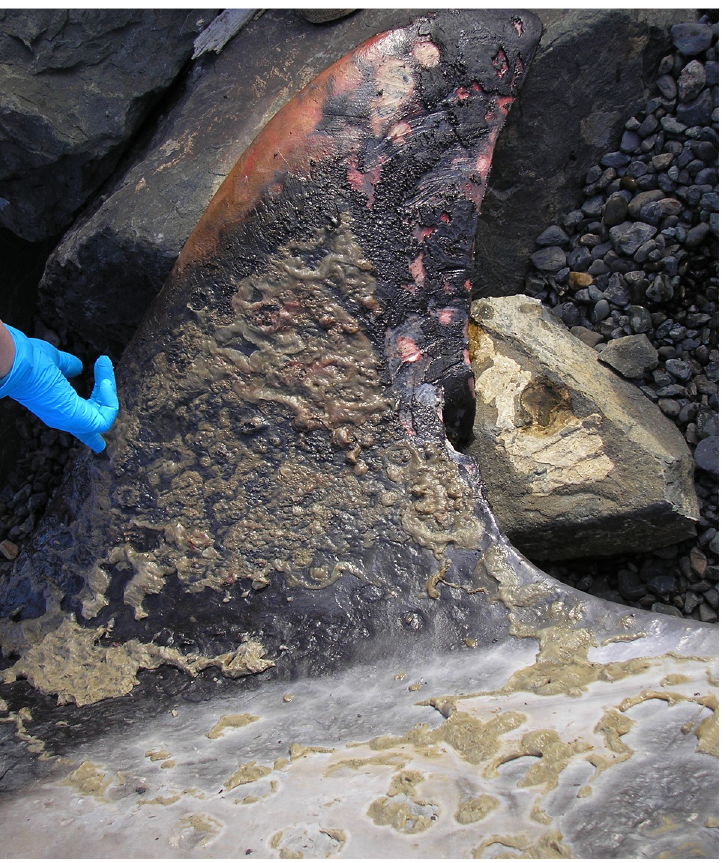
Fig 7. Skin lesions on dorsal fin of whale (ID# 20111008a) that experienced extended exposure to fresh water. This moderate to severe, multifocal to diffuse degenerative dermatitis characterized by cutaneous ulcers and erosions, superficial and deep cracking of the skin, and a generalized irregularity to the skin surface was noted in three whales (ID#s 20111008a, 20111008b, and